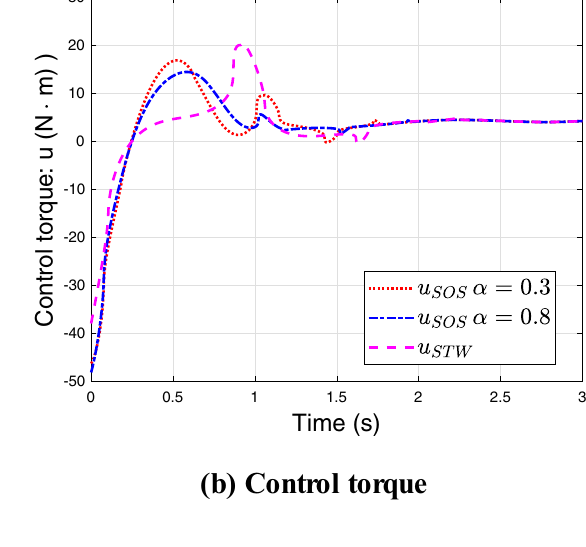
Fig. 3 Comparison of sliding variables and torques for SOSMC and